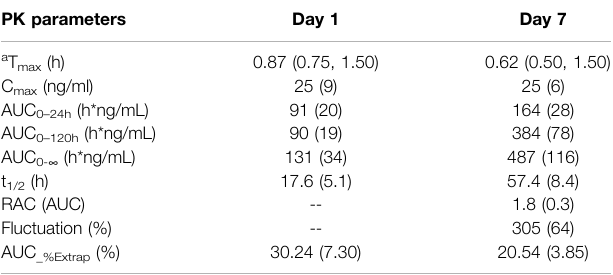
TABLE 3 | Pharmacokinetic parameters of tenofovir of the multiple-dose 25 mg group (mean ± SD; n = 8). PK